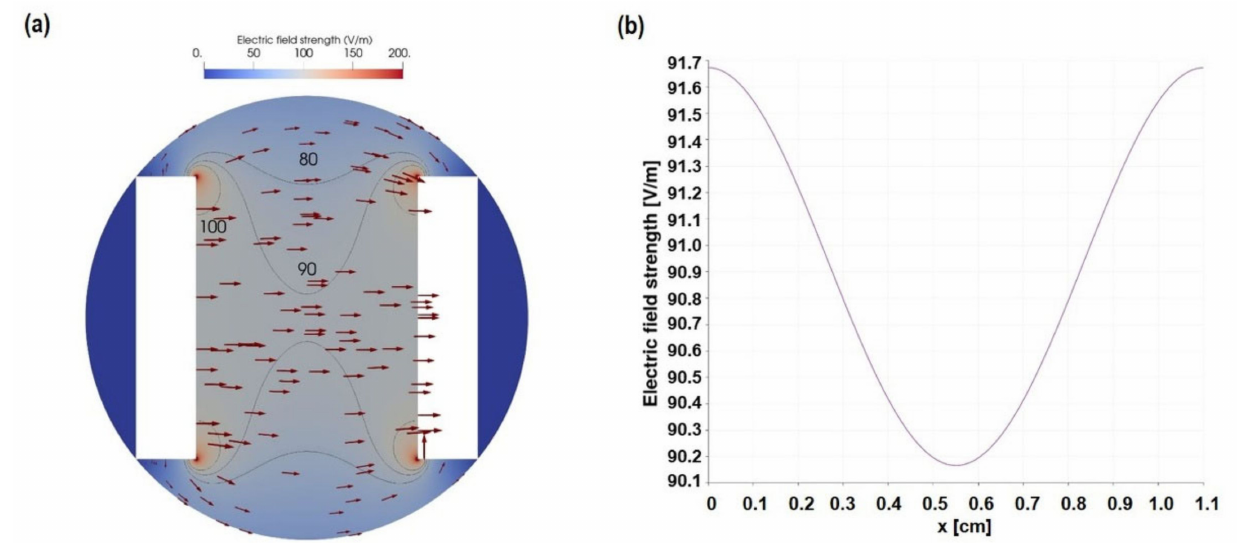
Figure 3. Simulation data revealed ( a ) the electric field distribution and strength (red arrows) between the two electrodes at a voltage difference of 1 V. The grey isolines highlight the regions where the field reaches 80, 90, and 100 V/m (the latter in the vicinity of the electrodes’ sharp corners), respectively. Furthermore, ( b ) shows the electric field strength along the centerline between the two electrodes. The result indicates that the cells are exerted to a mostly homogeneous field with a magnitude of about 90 V/m. Note that for different voltage differences, the field strength changes linearly w.r.t. the